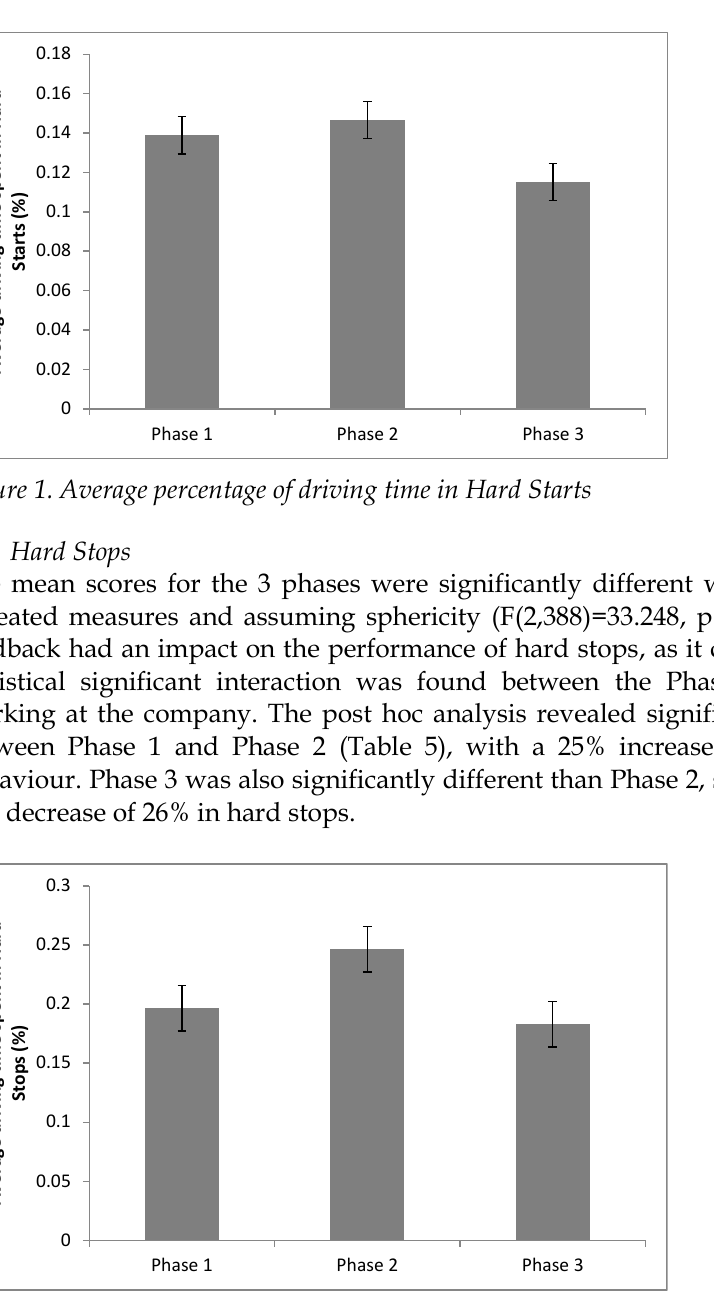
Figure 2. Average percentage of driving time in Hard